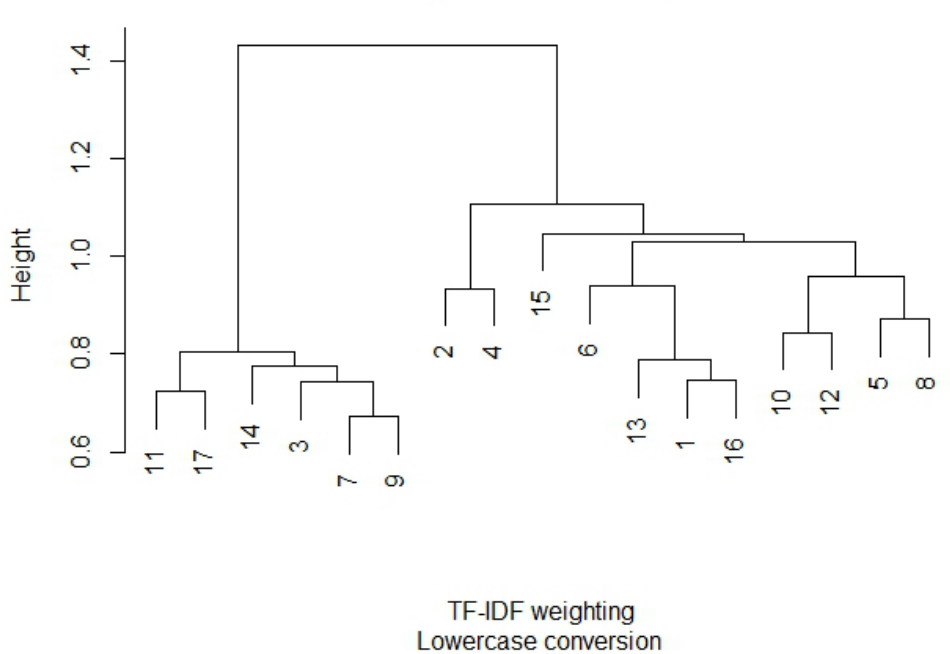
Figure 2: Hierarchical clustering of chapters using Ward's method with the Manhattan distance. The six V. storyline chapters stand out clearly on the left branch of the dendrogram. The picture is very similar using simple term frequency (TF) weighting without conversion to